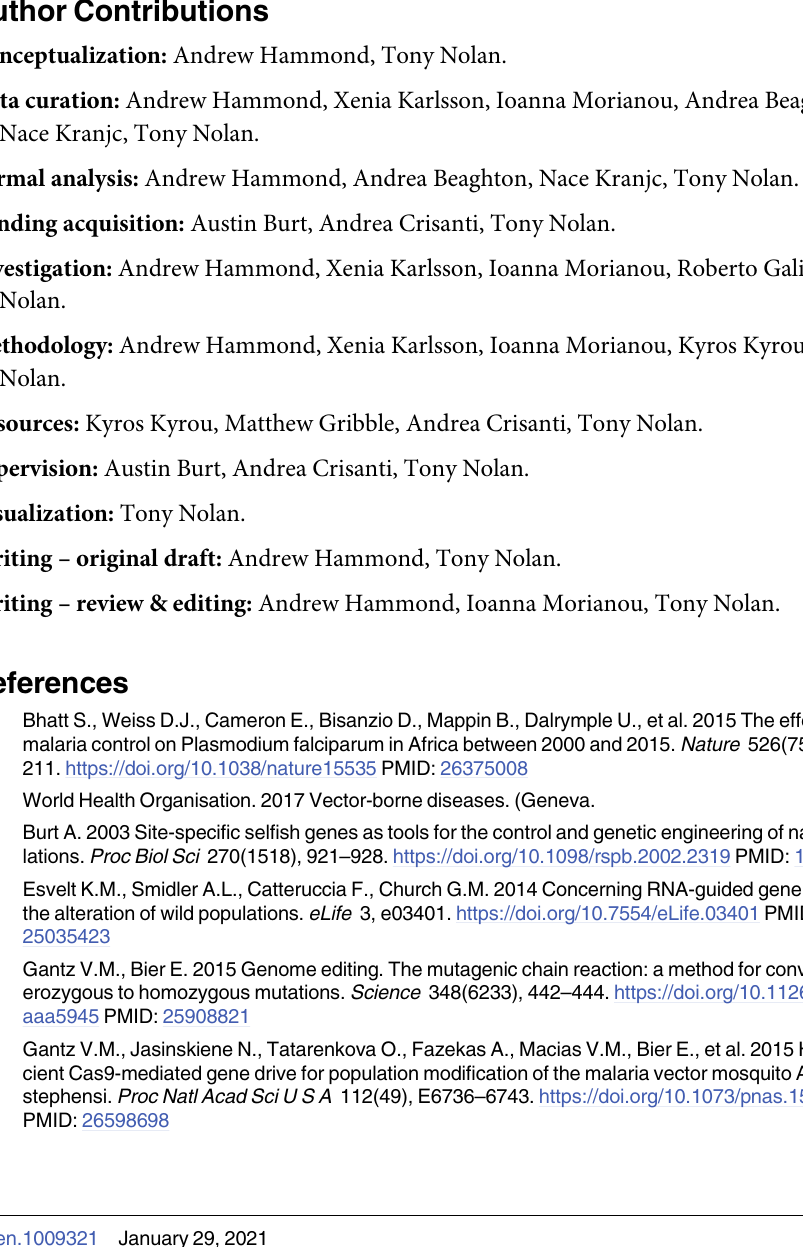
S3 Table. Primers used in this study to assemble the transformation vectors. S4 Table. Promoter and terminator sequences used in gene drive constructs. S5 Table. The proportions of germline stem cells of different genotypes arising from pater- nal effects. S6 Table. Genotype fitnesses and the proportion of each type of gamete produced by each